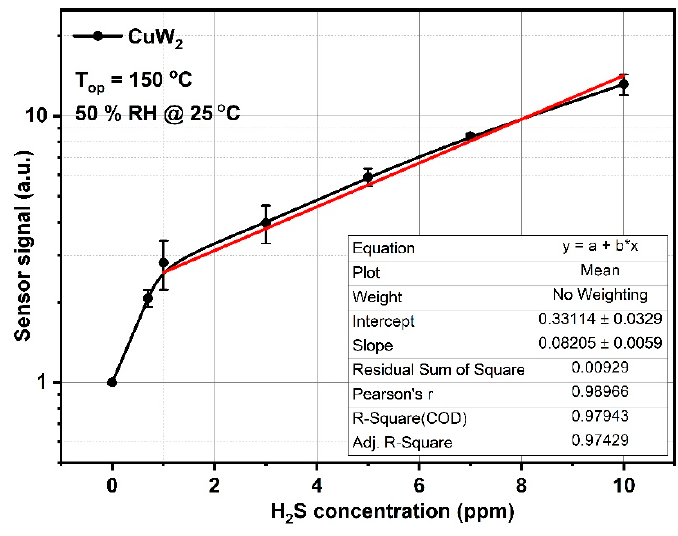
Figure 11. Sensor signal behavior with respect to the H 2 S concentrations. As a final step of the sensing evaluation, the CuW2 selectivity towards H 2 S detection against other possible interfering gases has been highlighted. Their concentrations have been chosen according to the EU detection limits (Figure 12).